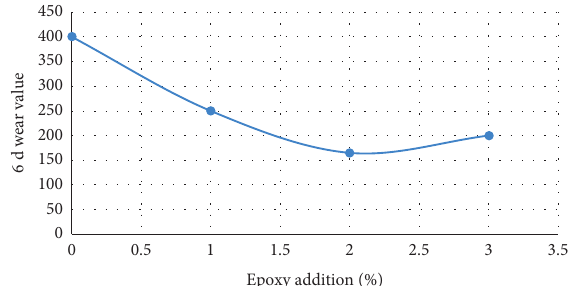
Figure 3: 6D wet-wheel wear values of high epoxy performance microsurfacing.